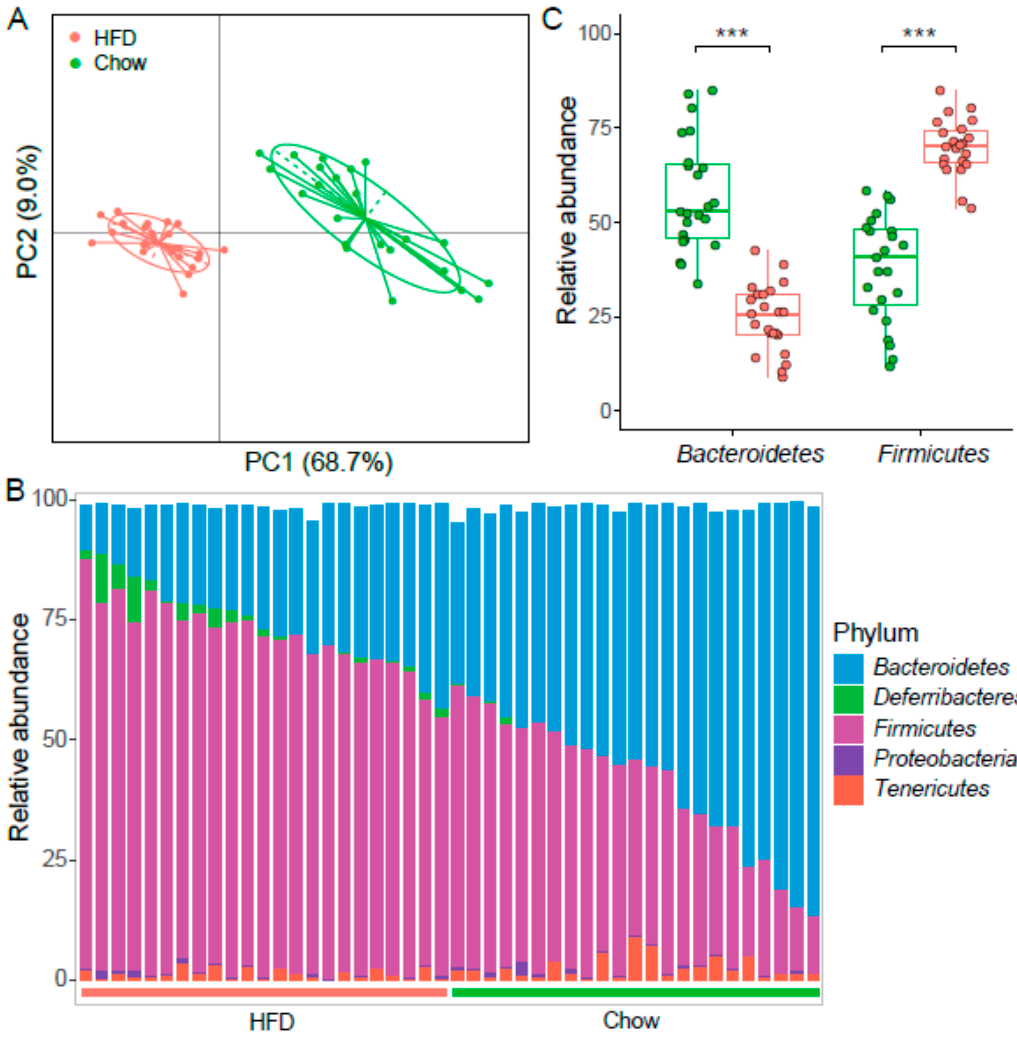
Figure 3. The structure of gut microbiota in two groups of mice. ( A ) PCoA based on weighted UniFrac distance of the OTUs abundance. The contributions of principal coordinate 1 (PC1) is on the X-axis and 2 (PC2) is on the Y-axis. ( B ) Bacterial taxonomic profiling at the phylum level among individuals is shown. Green bar represents chow samples, n = 23; red bar represents HFD samples, n = 23. ( C ) Boxplot of the relative abundance of Bacteroidetes and Firmicutes in samples from chow ( n = 23) and HFD group ( n = 23). *** denotes p <